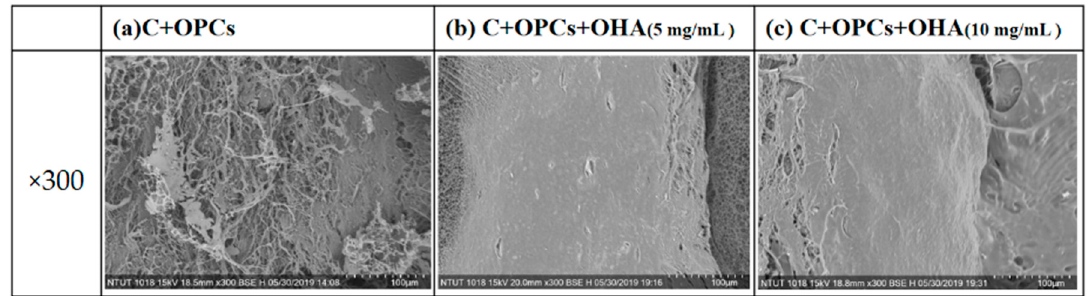
Figure 3. Surface morphologies of collagen + OPCs ( a ) and collagen + OPCs + OHA (5 mg/mL and 10 mg/mL) ( b , c ) observed by SEM (magnification 300 × ).